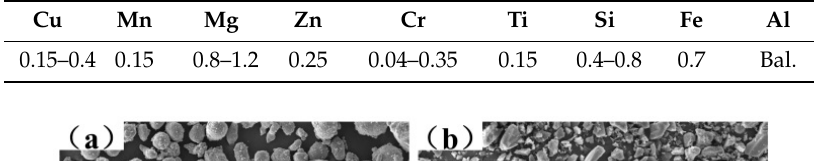
Table 1. The chemical composition of 6061 aluminum alloy (wt.%).